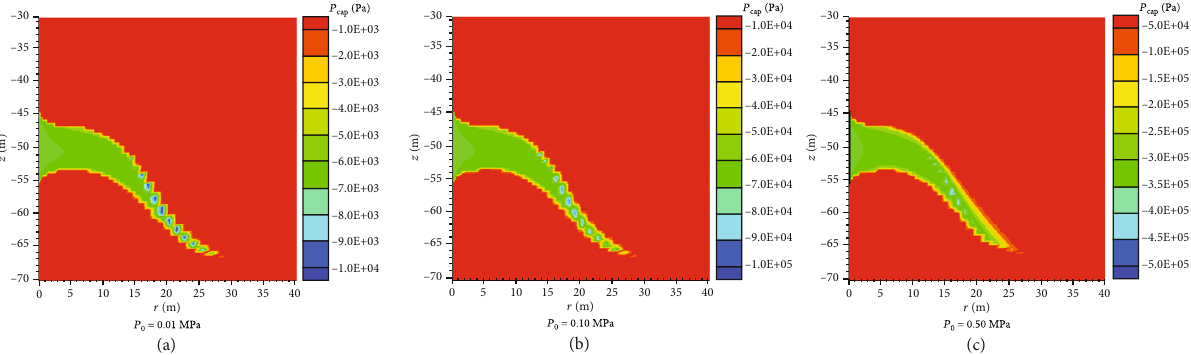
ff erent cases with di ff erent gas entry pressure P cap distribution in three di